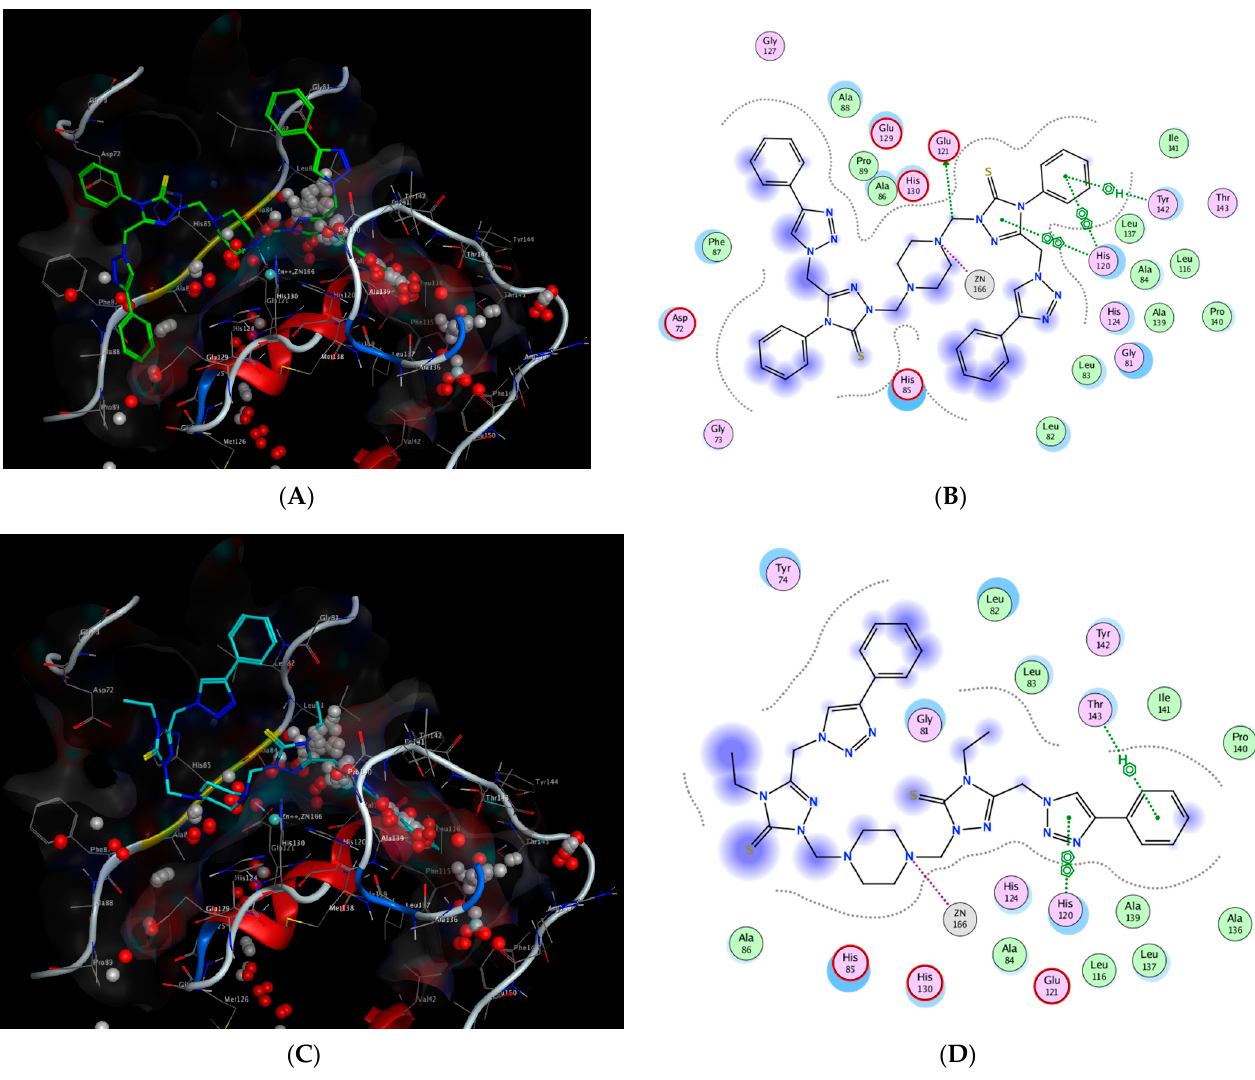
Figure 5. ( A ) Three-dimensional binding mode of 15 (green sticks), ( B ) 2D binding mode of 15 , ( C ) 3D binding mode of 16 (cyan sticks), and ( D ) 2D binding mode of 16 in MMP-2 catalytic domain (PDB ID: 1HOV [74]).